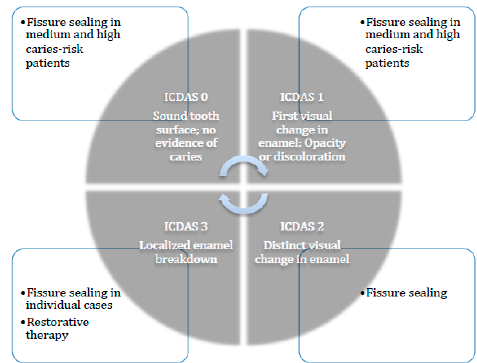
Figure 2. Treatment options depending on the ICDAS (International Caries Detection and Assessment System) codes.